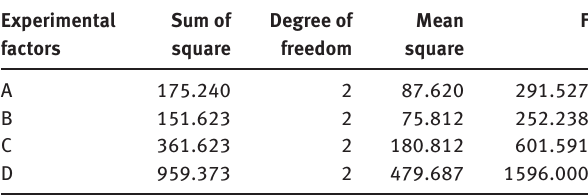
Table 5: Variance calculation of w (core) of